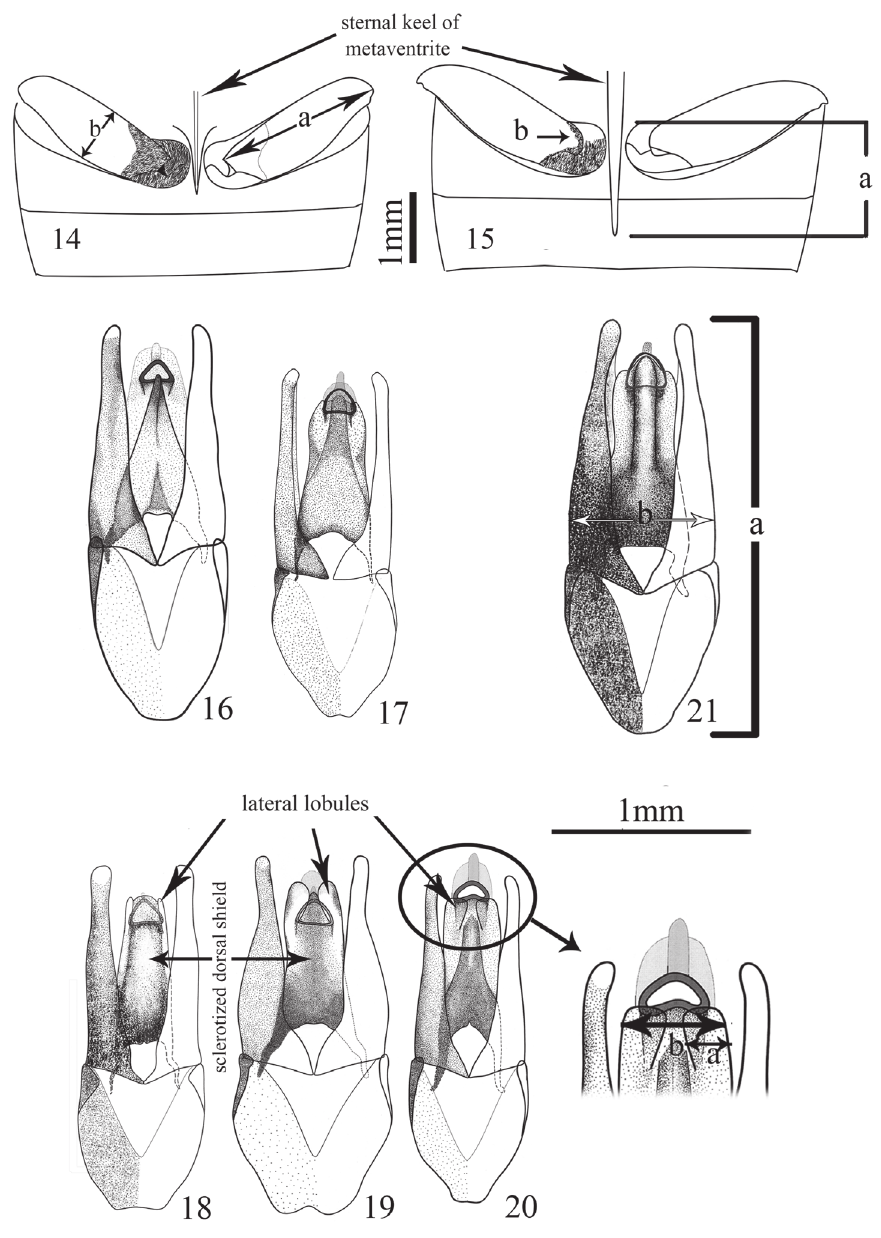
Figures 14–21. 14–15 Hind femur with the spine on metaventrite 14 Sternolophus acutipenis a length of femur b widest part of hind femur 15 S. mandelai a length of spine b basal pubescent area (modified from Nasserzadeh and Komarek 2017) 16–21 Dorsal view of aedeagus 16 Sternolophus acutipenis 17 S. angolensis 18 S. angustatus 19 S. immarginatus 20 S. marginicollis a lateral lobules at widest part of median lobe b total width of median lobe on apical portion of the sclerotized dorsal shield 21 S. solitarius a length b widest part of the parameres (modified from Nasserzadeh and Komarek